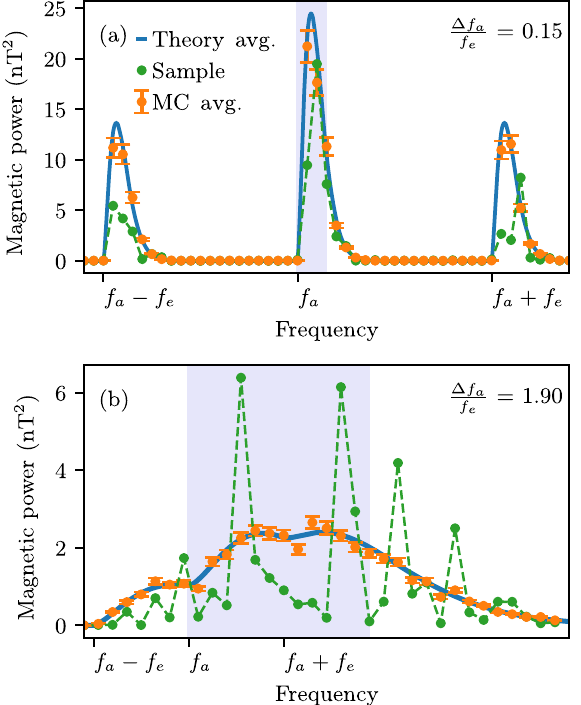
FIG. 3. Magnetic power spectrum for axion linewidths Δ f a ω =f < 1 and (b) Δ f =f > 1 . f = 2 π is where (a) Δ f a e a e e ¼ e Earth ’ s sidereal rotation frequency. We assume in these plots that the experimental frequency resolution is sufficient to fully resolve the axion ’ s line shape and that the experimental un- certainty at each point is negligible. The solid blue line is the mean theoretical power spectrum taken from Eq. (B52), while the orange points give the mean power from 100 Monte Carlo simulations. Orange error bars give the standard deviation of the mean power from the simulations. The green dots (with con- necting lines to guide the eye) show an example of one particular realization of a stochastic axion power spectrum. The data here 1 GeV − 1 . Notice are generated for a coupling constant of g aNN ¼ that for the same coupling constant, the peak axion power is lower for (b) compared to (a) due to the broadening of the axion peak for more massive axions. The shaded area denotes the frequency Δ f ; f span ½ f a a þ a (cid:2)